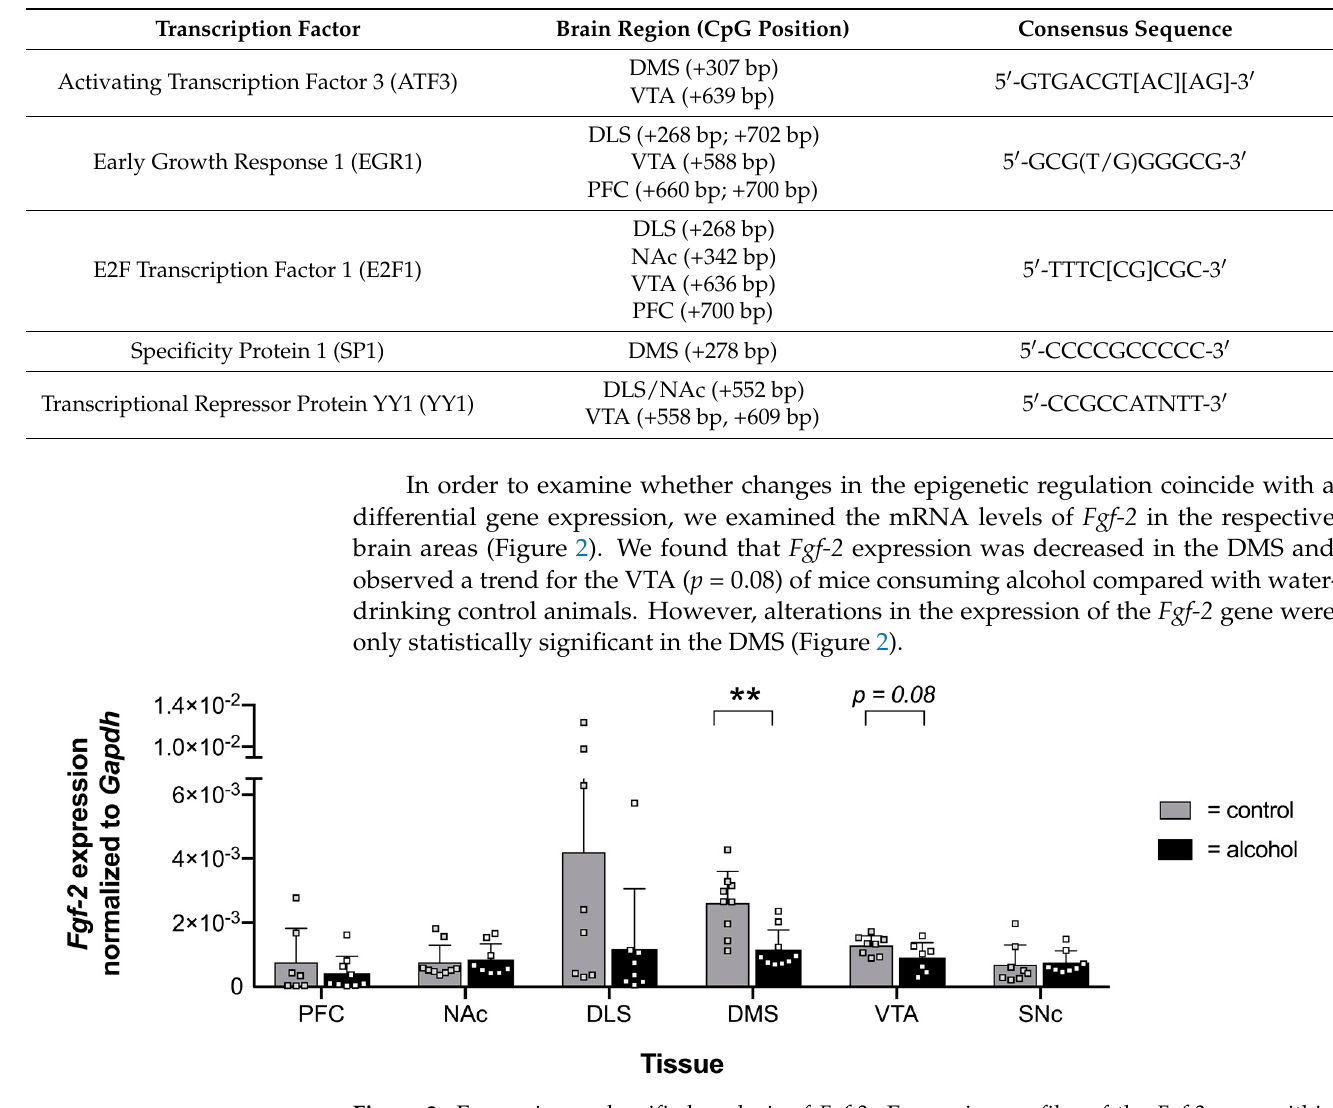
Table 1. Prediction of transcription factor binding sites within the fibroblast growth factor 2 ( Fgf-2) promoter. Factorbook was used for binding site prediction (https://www.factorbook.org/, accessed 24 August 2021).